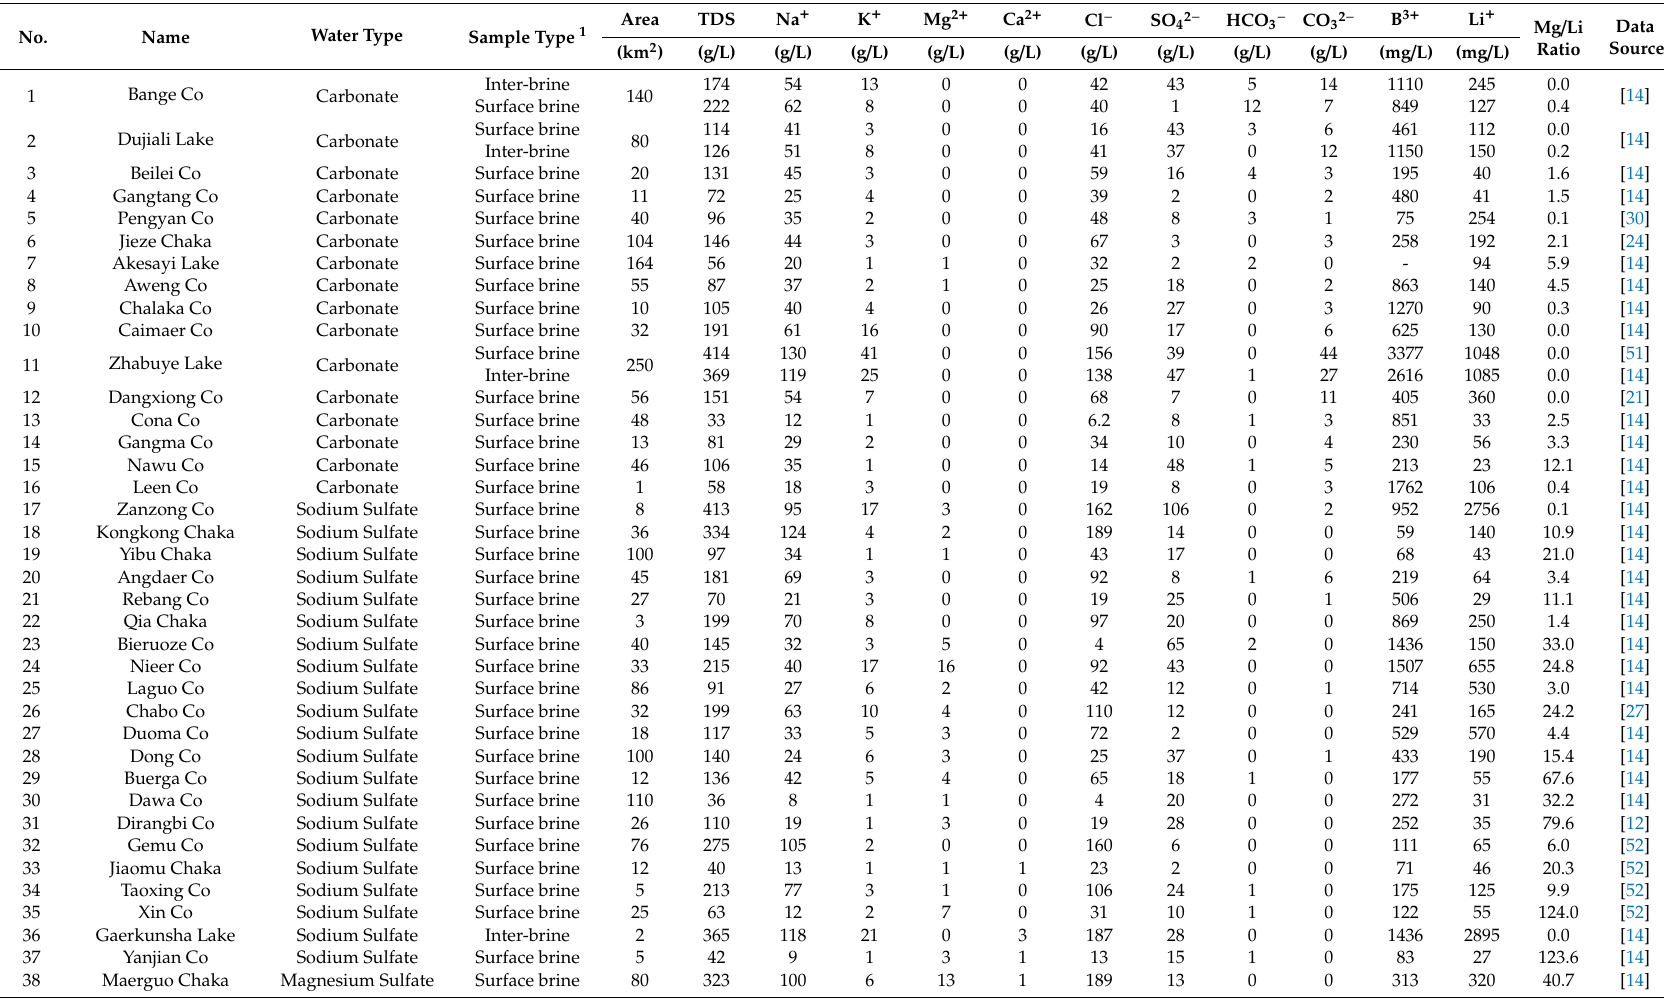
Table 1. Major and trace (Li, B) ionic compositions, lake areas, hydrochemical types, Mg / Li ratios of di ff erent Li-rich salt lakes on the Qinghai-Tibetan Plateau.